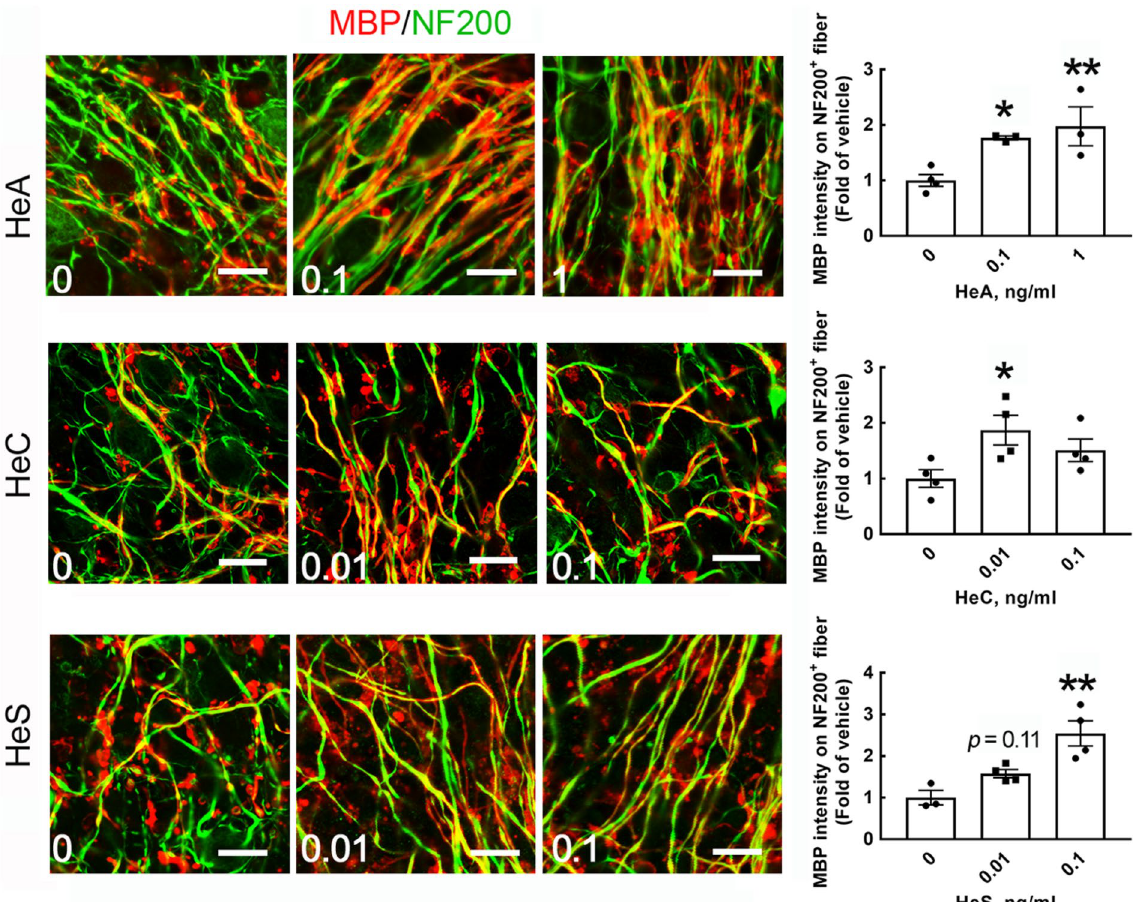
Figure 7. HeA and HeS enhanced the ensheathment of neuronal fibers with MBP + -cell processes. As described in Fig. 6A, cerebellar tissue slices were treated with HeA, HeC, or HeS at the indicated concentrations for 7 days. NF200 (green) and MBP (red) double immunofluorescence was conducted. Representative images were captured by confocal microscopy, and the overlap between the MBP signal and NF200 + -neuronal fibers in 4 random fields per culture was quantified as described in “Materials and methods” section (right panel). The results are presented as the means ± SEMs of three repeated experiments. * p < 0.05, ** p < 0.01 compared with the corresponding control culture. Scale bar, 20